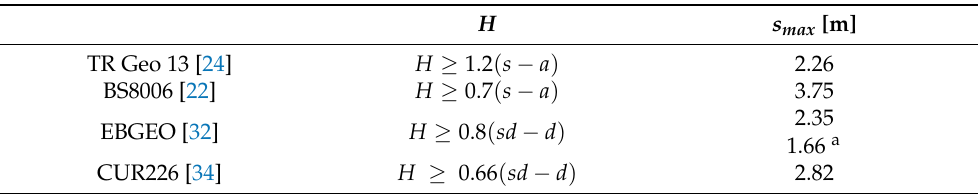
Table 4. Maximum value of s ( s max ) for H = 2.5 m, calculated using geometrical limits in the guidelines